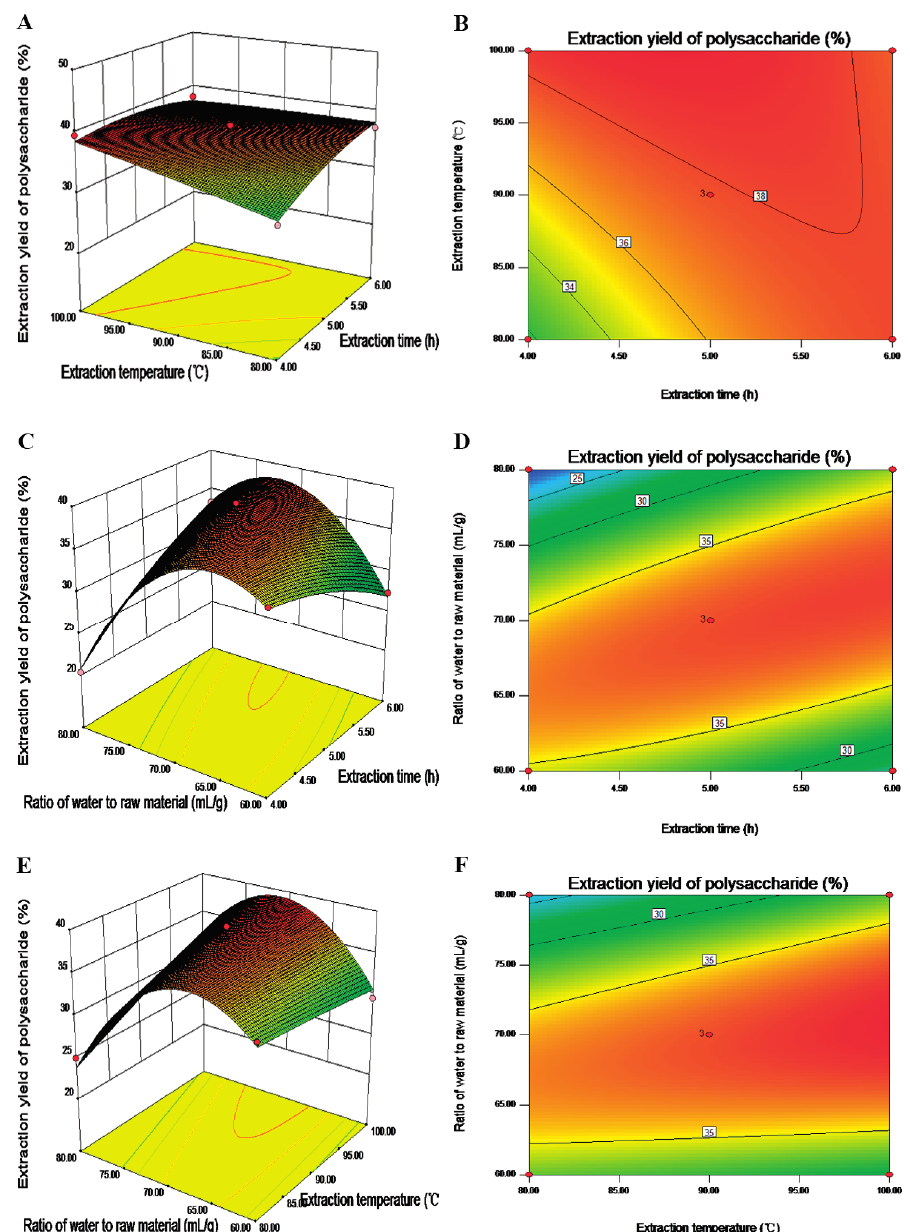
Figure 2. Response surface plots ( A , C , E ) and contour plots ( B , D , F ) showing the interactive effects of extraction time (X 1 ), extraction temperature (X 2 ) and ratio of water to raw material (X 3 ) on yield of GL